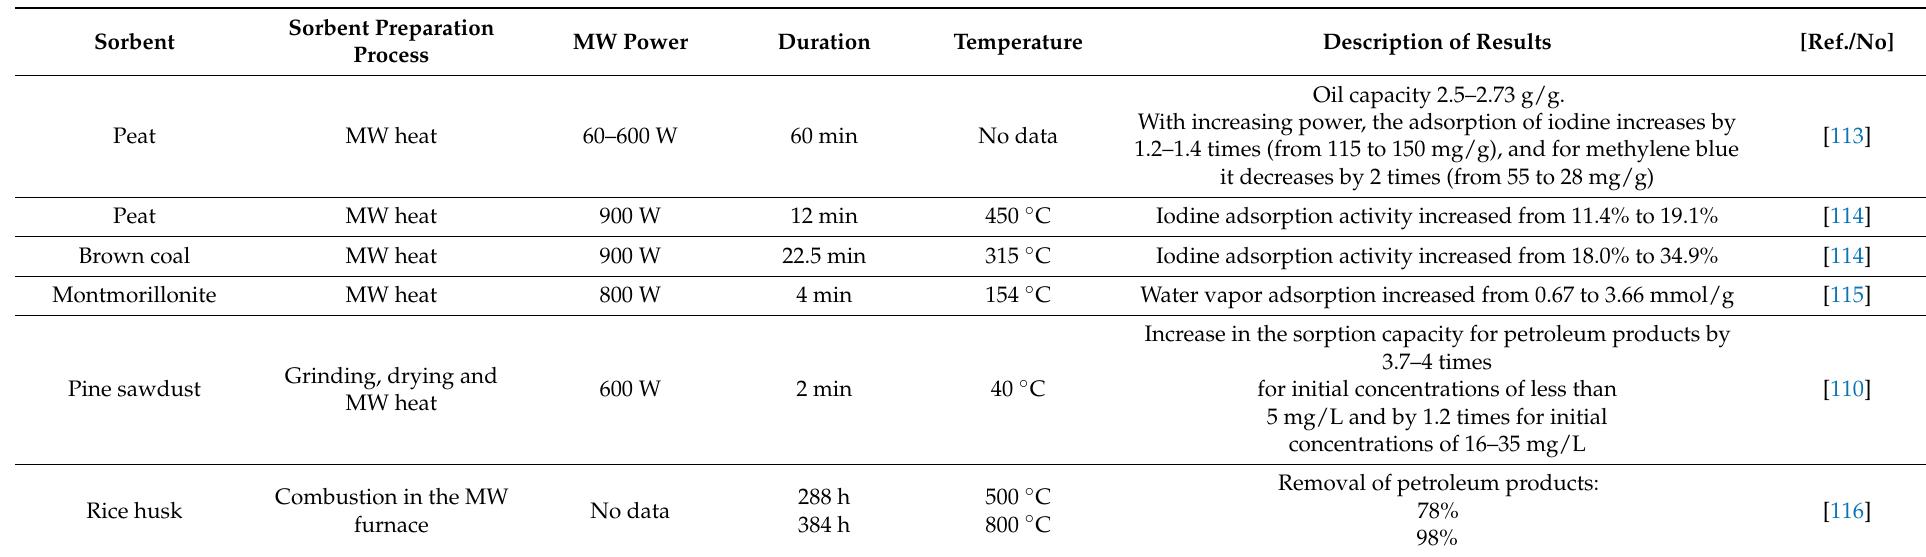
Table 10. Results of MW processing of sorbents based on natural